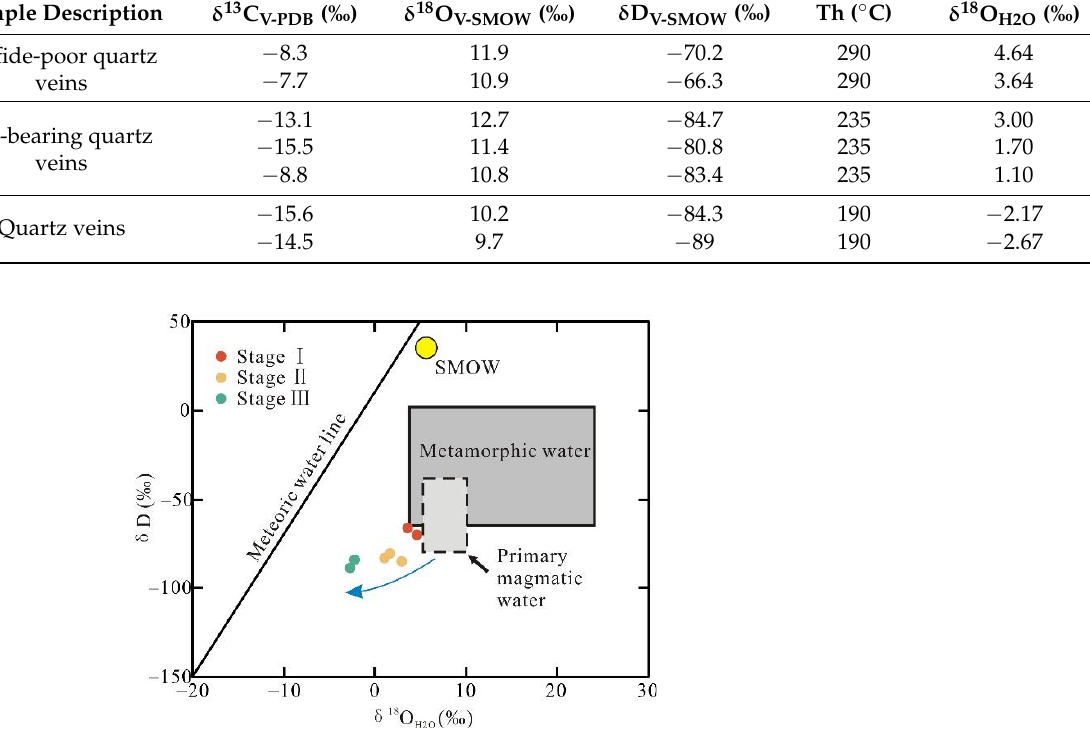
Table 2. Hydrogen, oxygen, and carbon isotope data of inclusion fluids from the different hydrothermal stages in the Toudaochuan deposit.